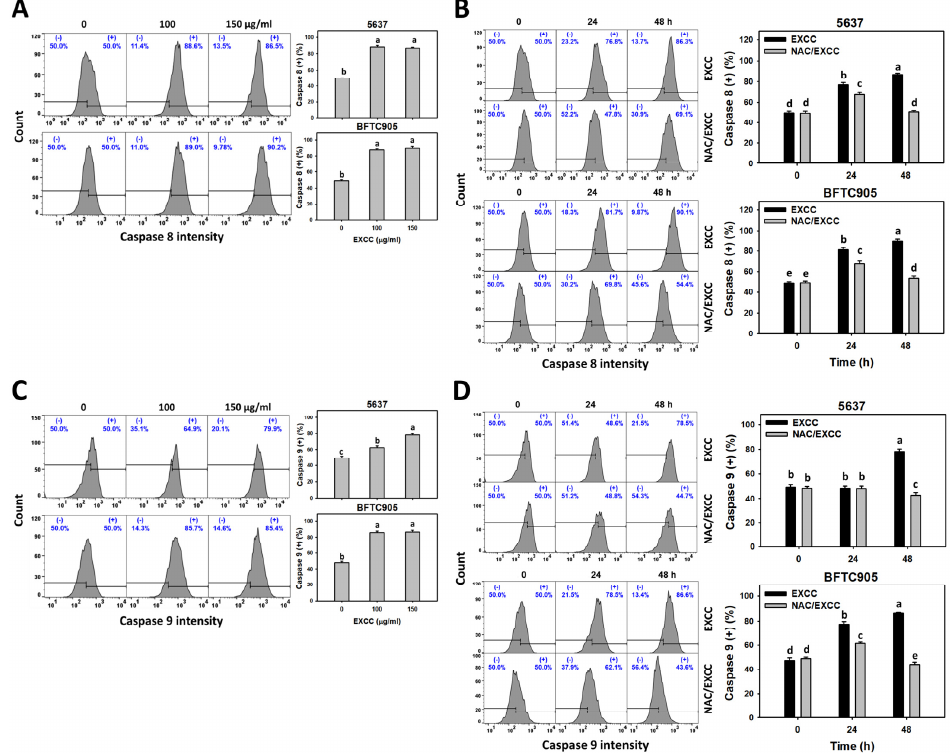
Figure 5. Cas 8 and Cas 9 changes by EXCC. ( A , C ) Cas 8 and Cas 9 assays of EXCC. Two bladder cancer cell lines (5637 and BFTC905) were tested. Cells were treated with control (0.1% DMSO) and EXCC (100 and 150 μ g/mL) for 48 h. (+) represents the Cas 8 or Cas 9 (+) population. ( B , D ) Cas 8 and Cas 9 assays of NAC/EXCC. NAC/EXCC is the NAC pretreatment (10 mM, 1 h) coupled with EXCC posttreatment (150 μ g/mL, 24 and 48 h). Statistical lower-case letters were given to each treatment. Non-overlapping letters between different treatments indicate significant results ( p < 0.05). Data, means ± SD ( n = 3). For example (5637 cells in Figure 5B), the EXCC (black color) 0, 24, and 48 h indicating “d, b and a” show significant results between each other because these letters were non-overlapping. In contrast, EXCC 0 (black color) and NAC/EXCC (gray color) 0 h indicating “d” show nonsignificant results because these letters